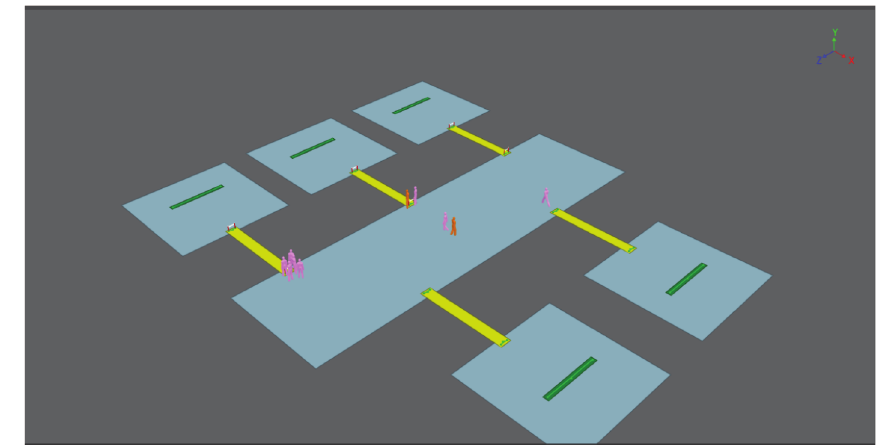
Figure 6: Massmotion simulation